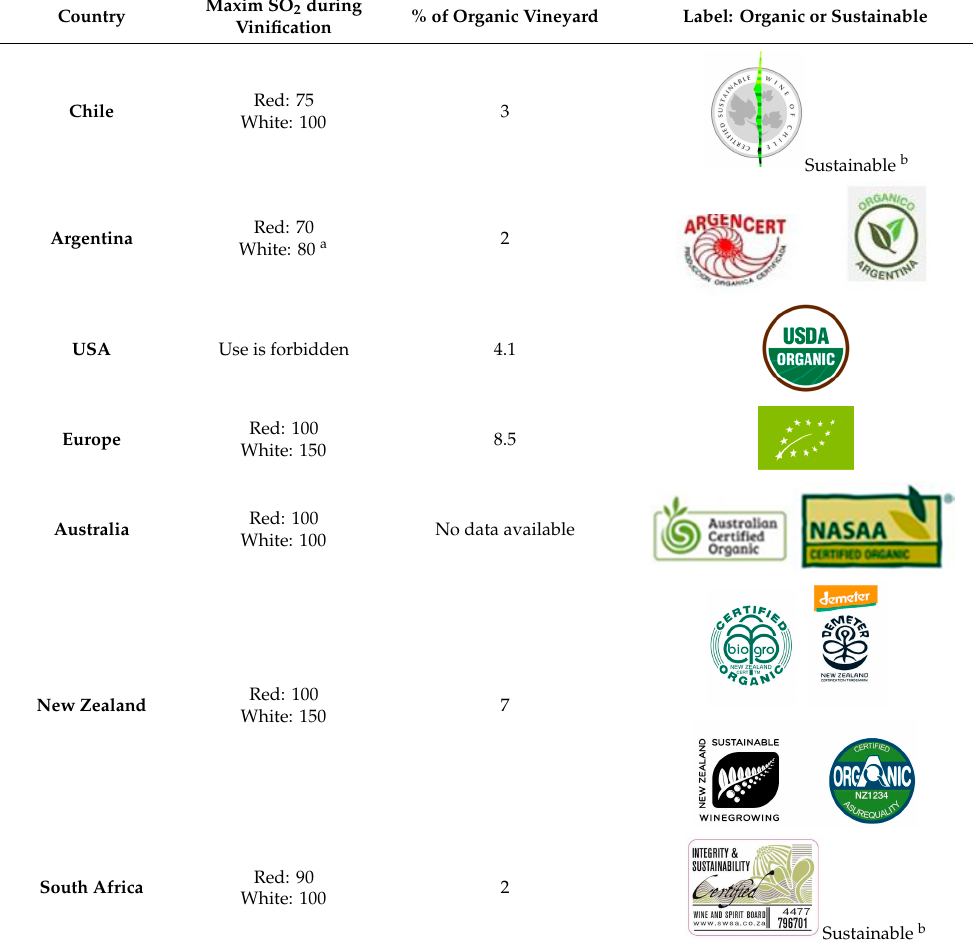
Table 1. Difference about regulation in terms of maximum use of SO 2 (mg/L) allowed during vinification, the percentage of the organic vineyard in the country (data from 2015 to 2016), and the organic wine label used on their local market [7]. Maxim SO 2 during Country Vinification